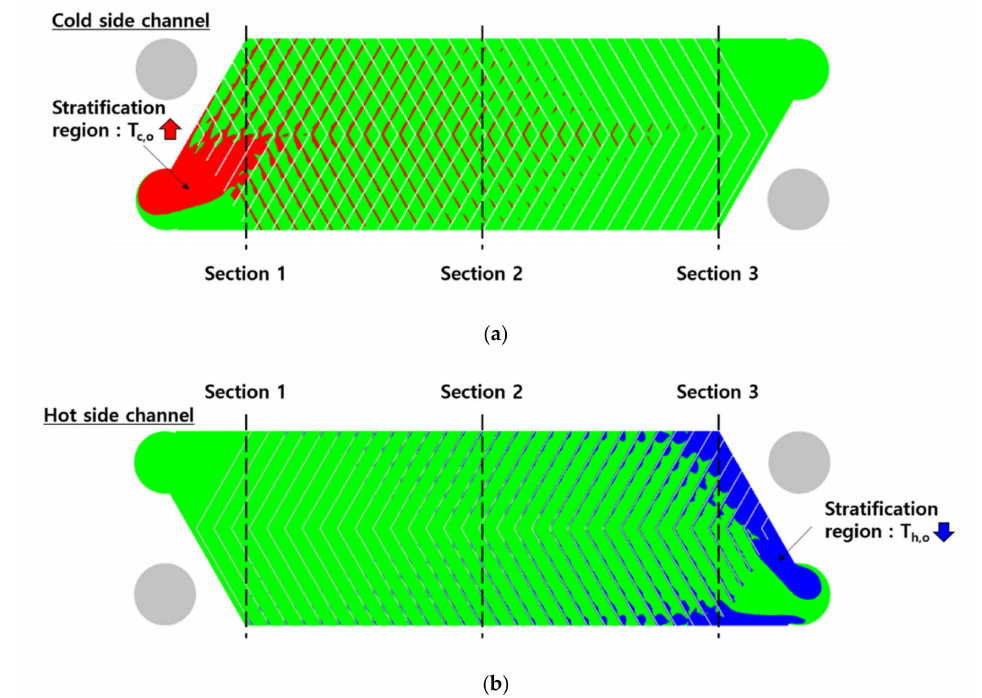
Figure 8. A subcooled region at the channel of the plate heat exchanger: ( a ) at cold side channel and ( b ) overheated region at the hot